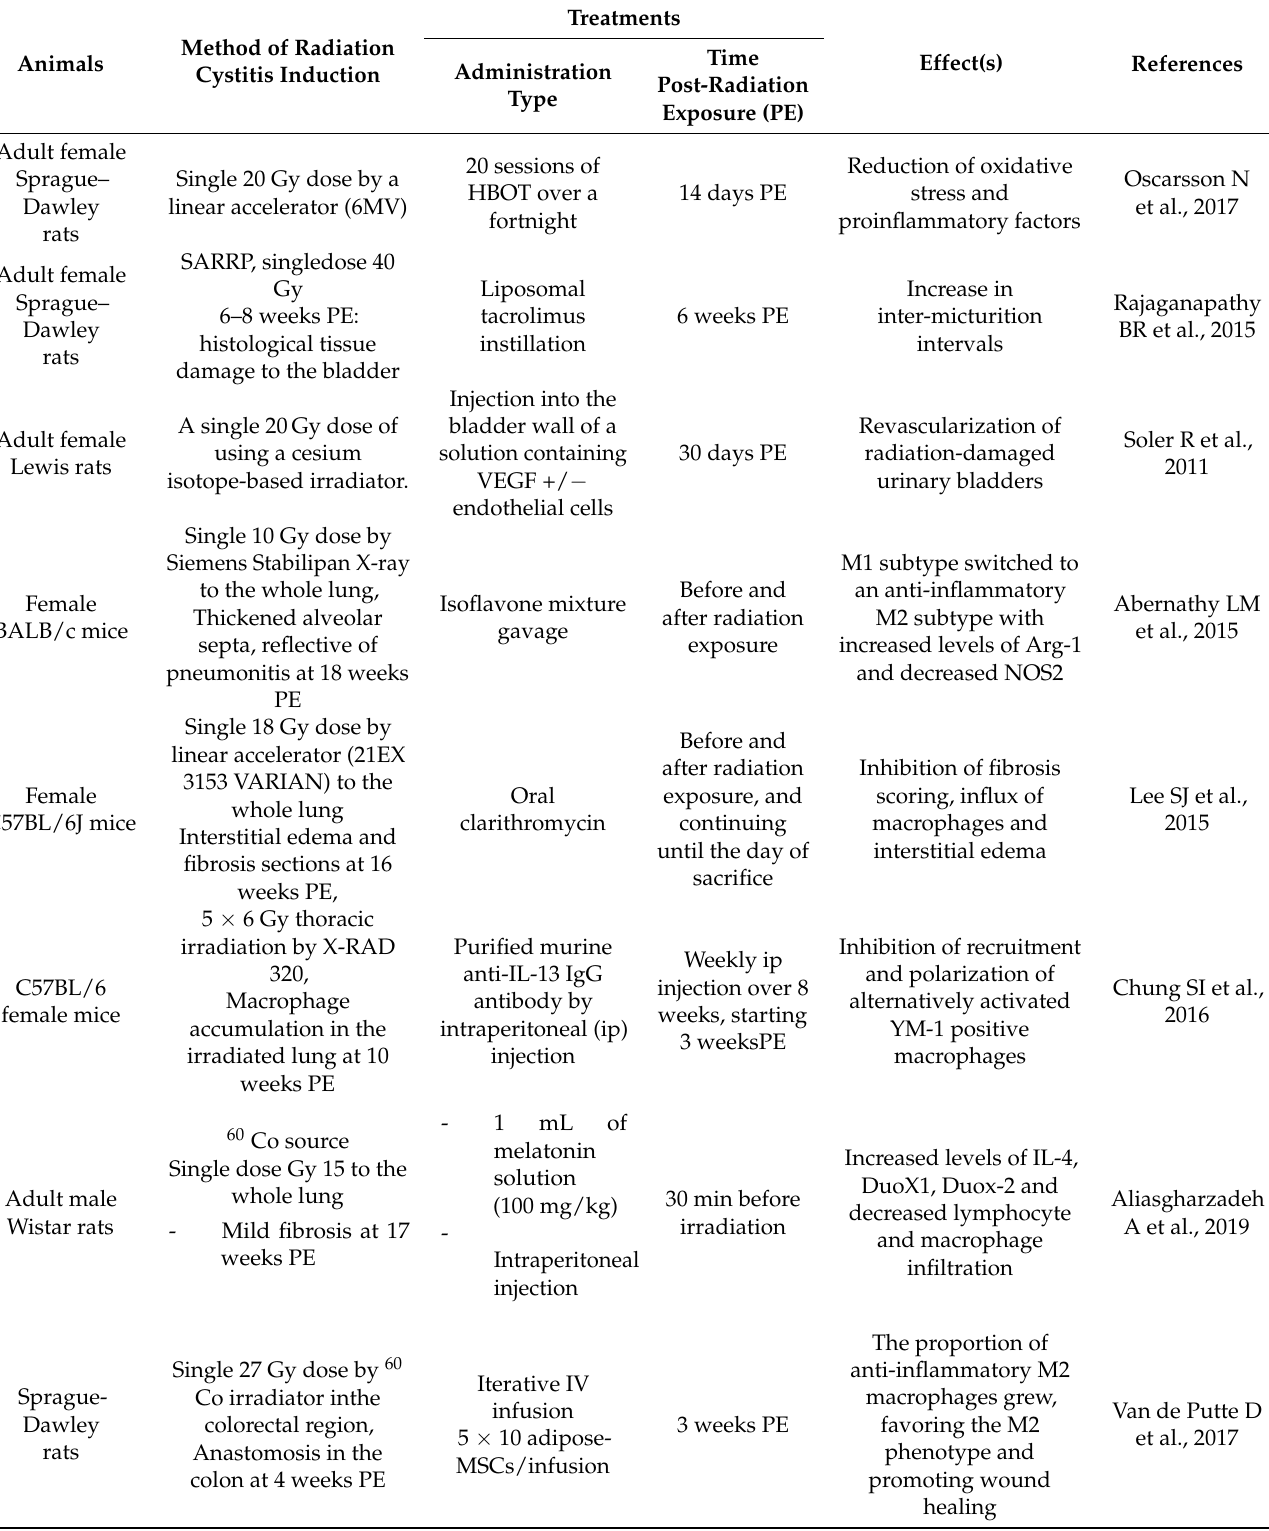
Table 1. Recent animal models for preclinical studies of radiation cystitis (RC) and preclinical studies targeting immune cells to limit the development of radio-induced